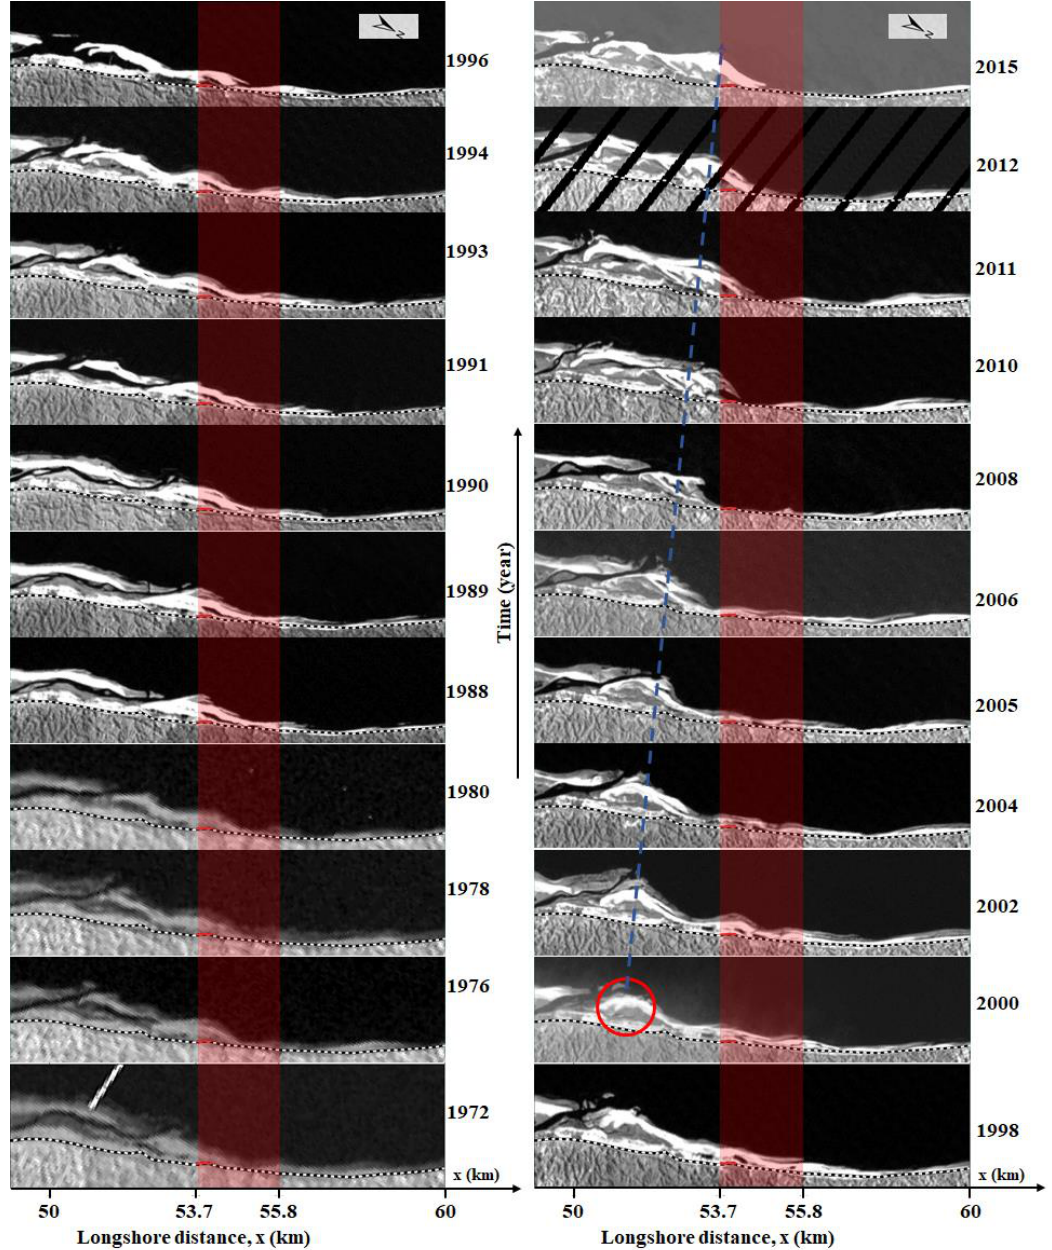
Figure 7. Time stack of Landsat images near the Reju River mouth. The black oblique lines in the image (2012) are due to a malfunction in the Landsat imaging sensor. The red shadowed area is the eroded area of 2006–2008 along the Marine Drive Road. The Marine Drive Road is shown with black and white dashed lines. The blue dashed line indicates growth of the sand spit to the north.